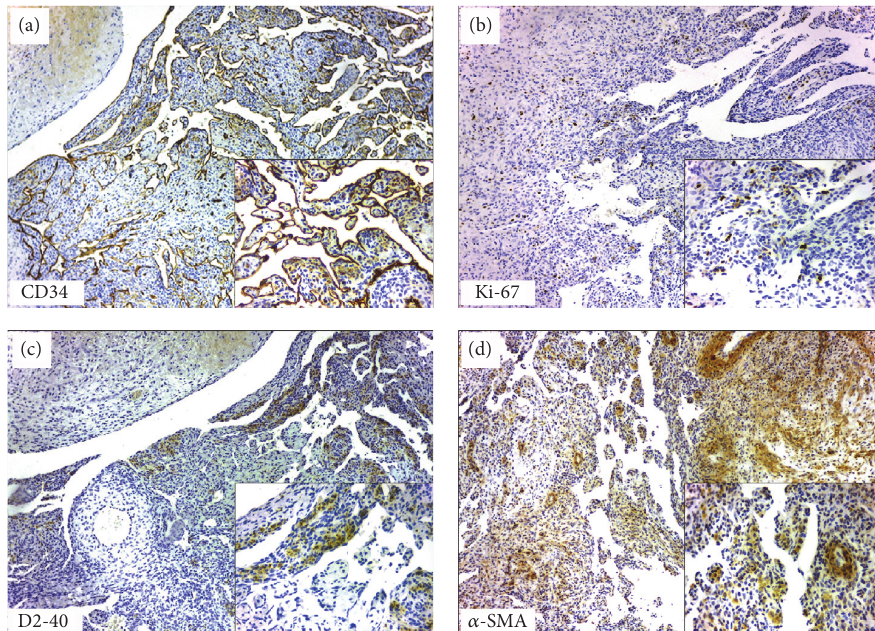
Figure 3: Immunohistochemical findings. CD34 was strongly positive highlighting the papillary endothelial proliferation (a) with low Ki- 67 proliferation index (4%) (b). D2-40 was negative (notice the hemosiderin deposits) (c), whereas 𝛼 -SMA stained the vessel walls (d) (all figures, × 10; all insets ×